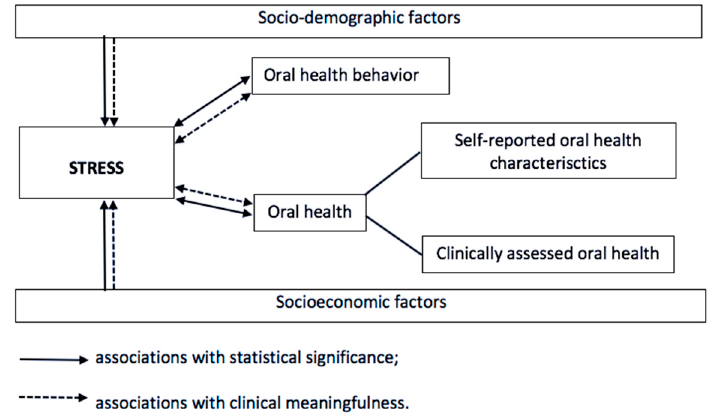
Figure 1. Conceptual framework of the study.